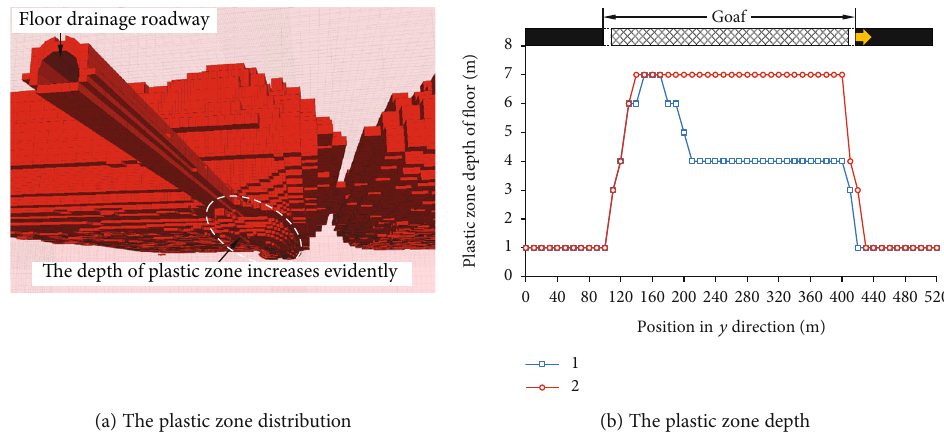
Figure 5: The plastic zone depth under the in fl uence of two working faces arranged at an internal stagger of 25